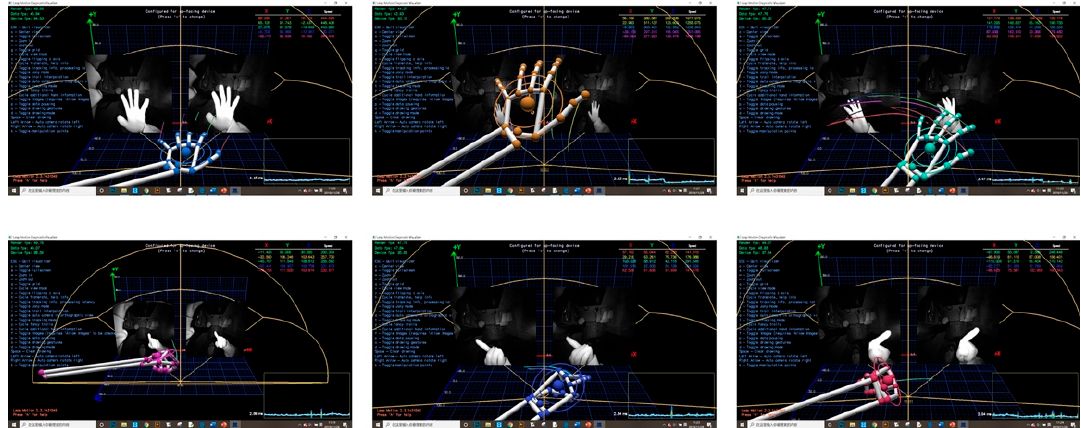
Figure 5. Display with gesture recognition via the Leap Motion Visualizer (from left to right and top to bottom: close to, away from, wave hand, swipe left, swipe right, click). Table 3. The posture classification and recognition accuracy of six gestures on leap motion. Posture Gesture